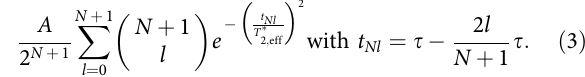
states: the logical eigenstate state |0,0 i L , the logical superposition